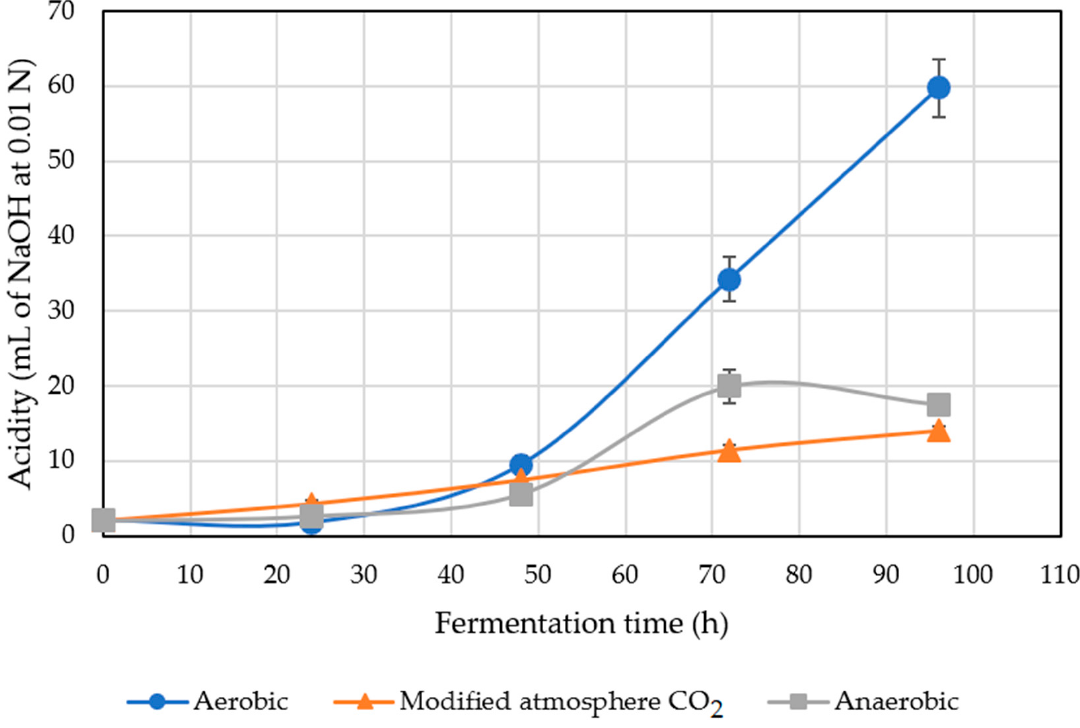
Figure 2. Acidity of the treated coffee.